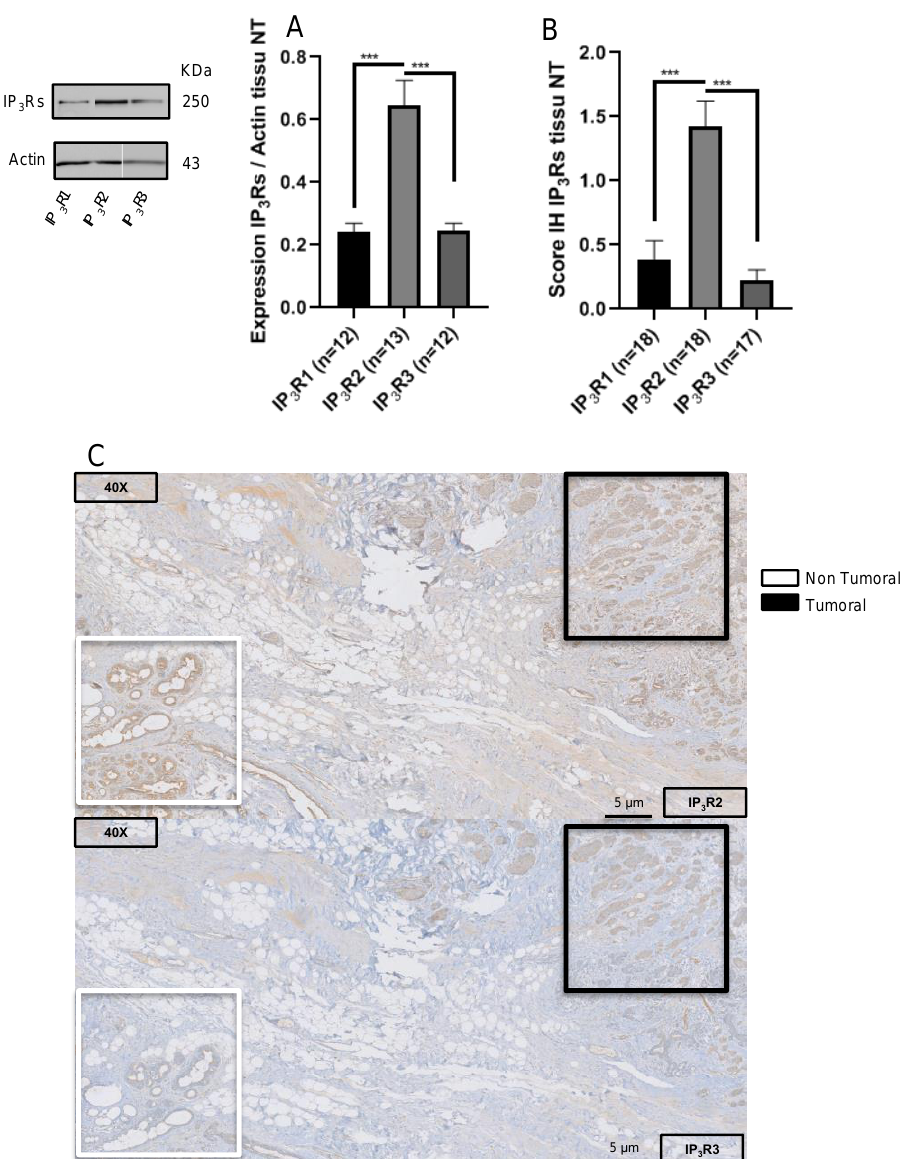
Figure 6. IP 3 R expression in non-tumor tissue. ( A ) Western blot analysis of the relative expression of IP 3 R1/2/3. ( B ) The IH expression score for IP 3 R1/2/3. ( C ) Representative IH images. *** p < 0.001.